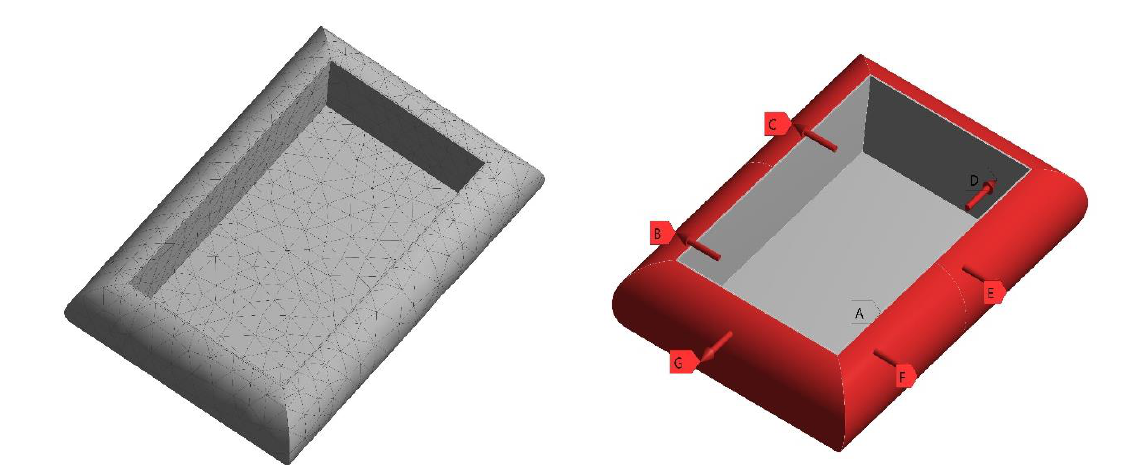
Figure 10. FE skirt model with mesh Figure 11. FE skirt with boundary conditions